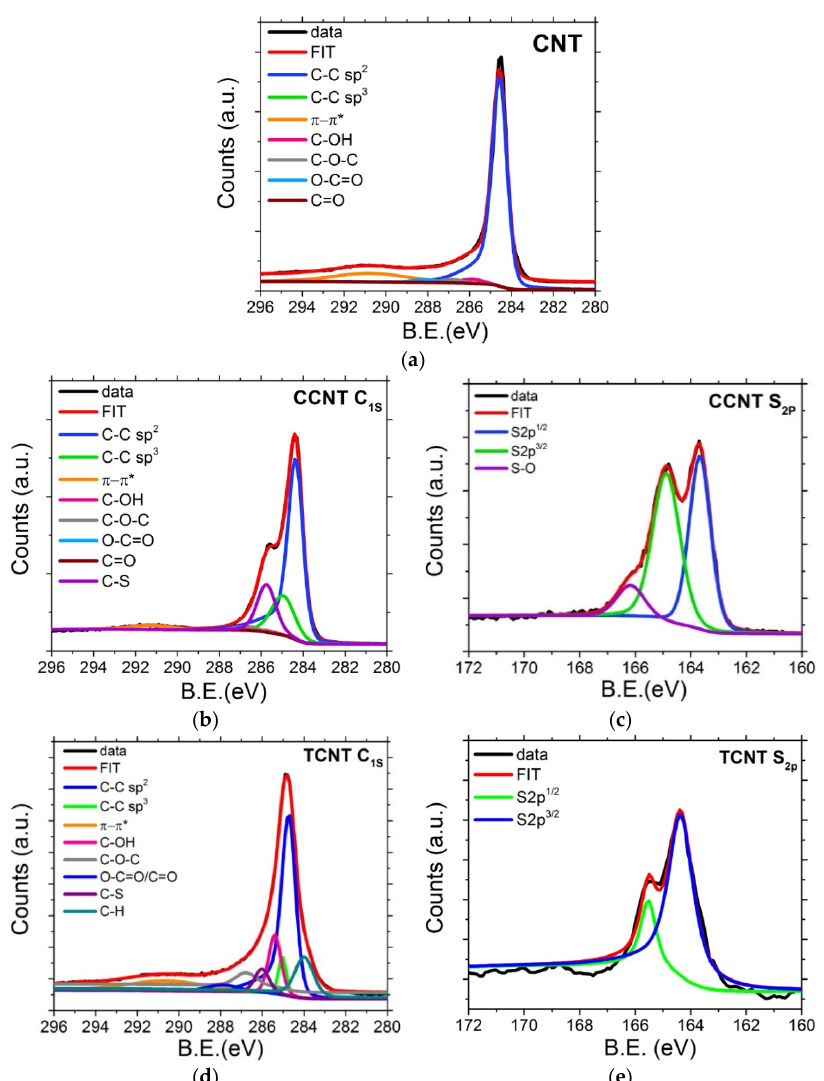
Figure 7. High resolution C1s and S2p X-ray photoelectron spectroscopy (XPS) spectra of ( a ) CNTs, ( b , c ) CCNTs, and ( d , e ) TCNTs. Solid lines are fitting curves of the spectra.